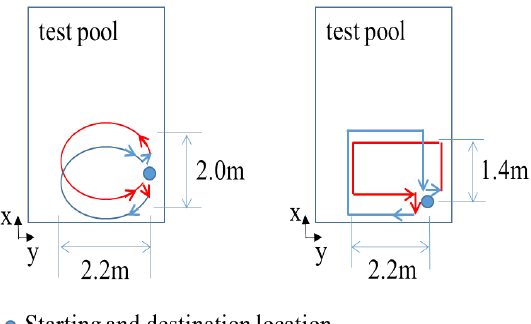
Figure 7. Two trajectories in navigation experiment 2